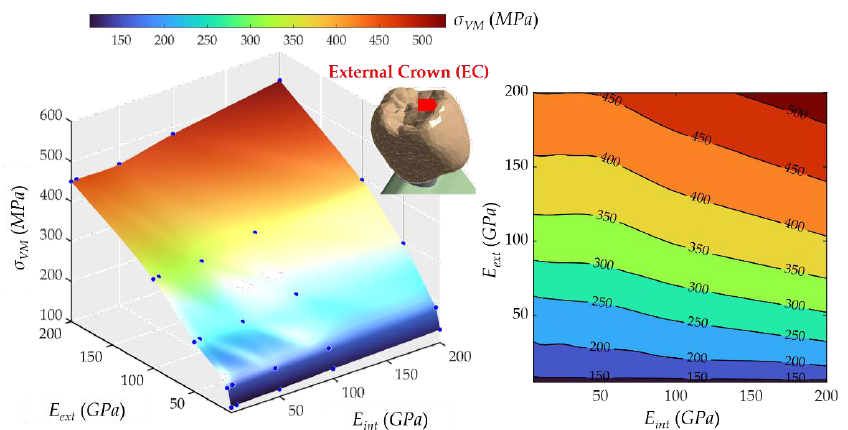
Figure 5. Von Mises maximum stress at the external crown (EC). ( Left ): 3D representation. ( Right ): vertical projection.